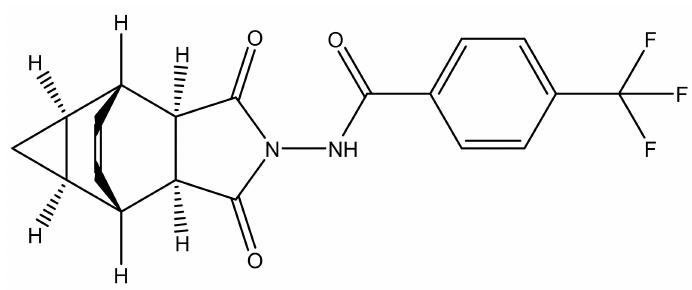
Figure 3. Chemical structure of